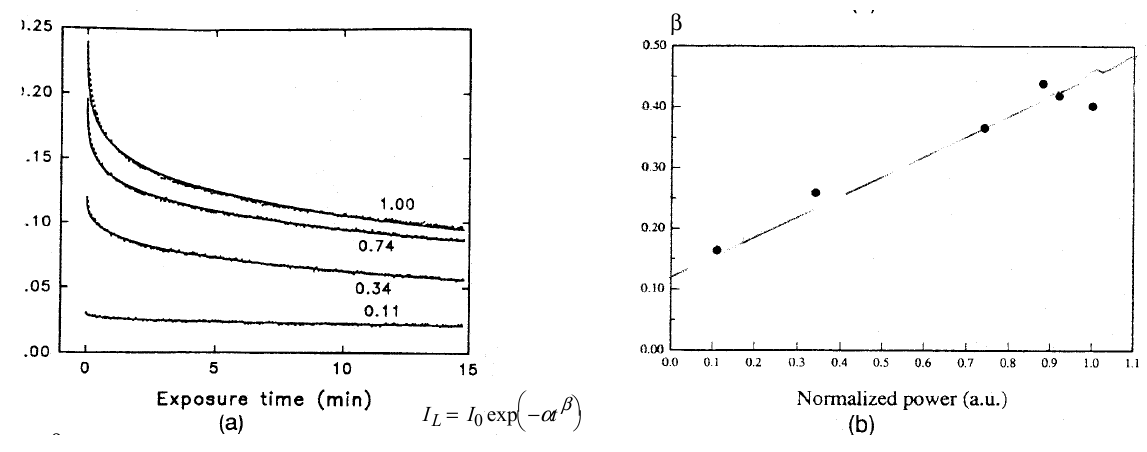
Figure 6. IR Hydrogen induced darkening, reprinted with permission from [14]. Copyright 1983 IEEE.